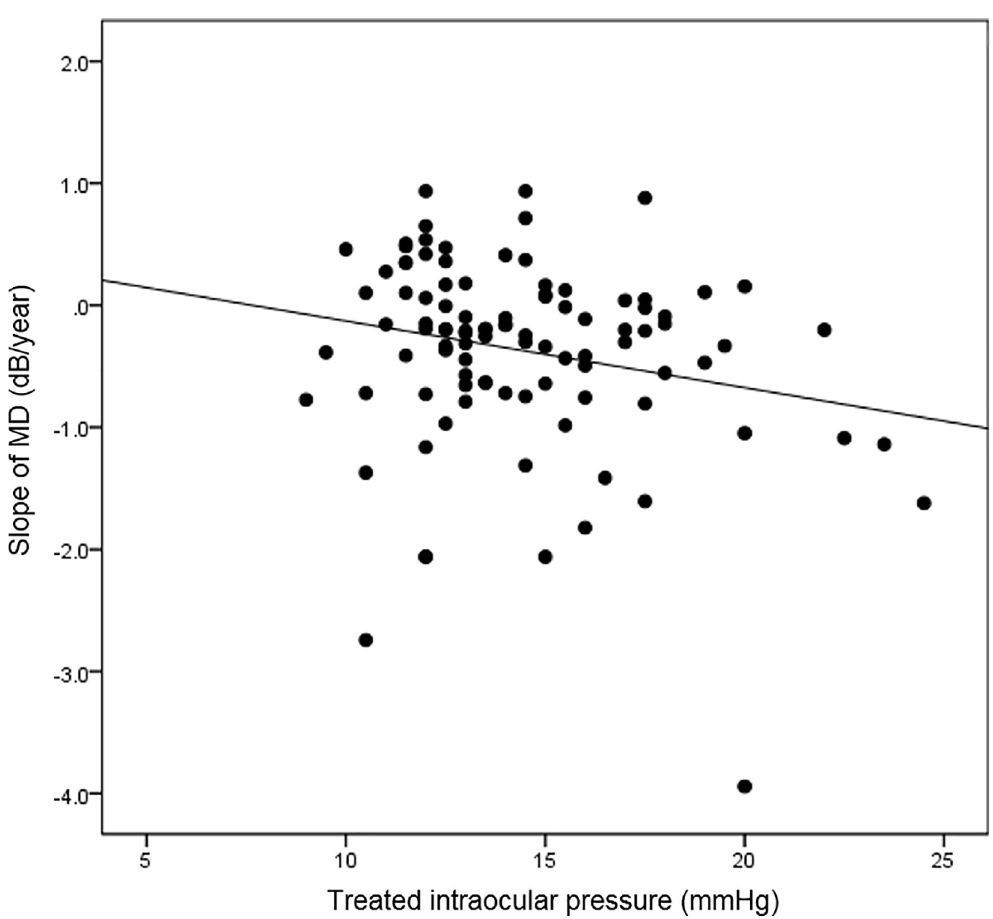
Fig 2. Scatter plot showing the relationship between treated intraocular pressure and visual field progression rate. MD = mean